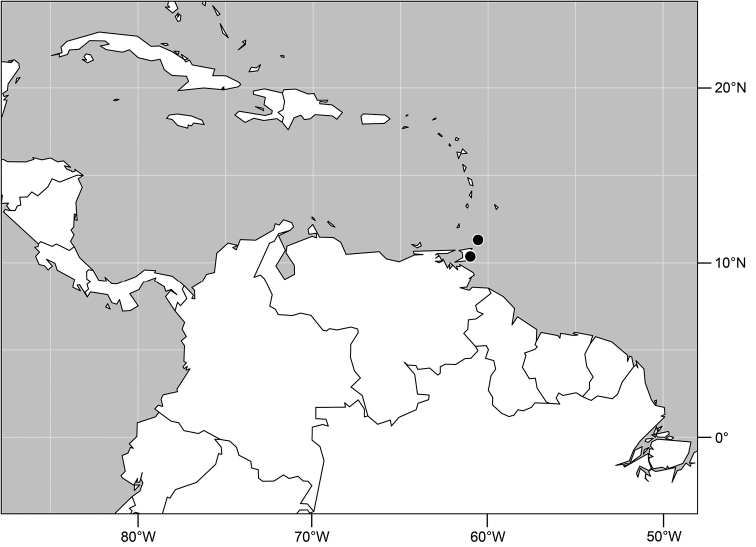
Distribution of Polytrichophora sinuosa sp. n.